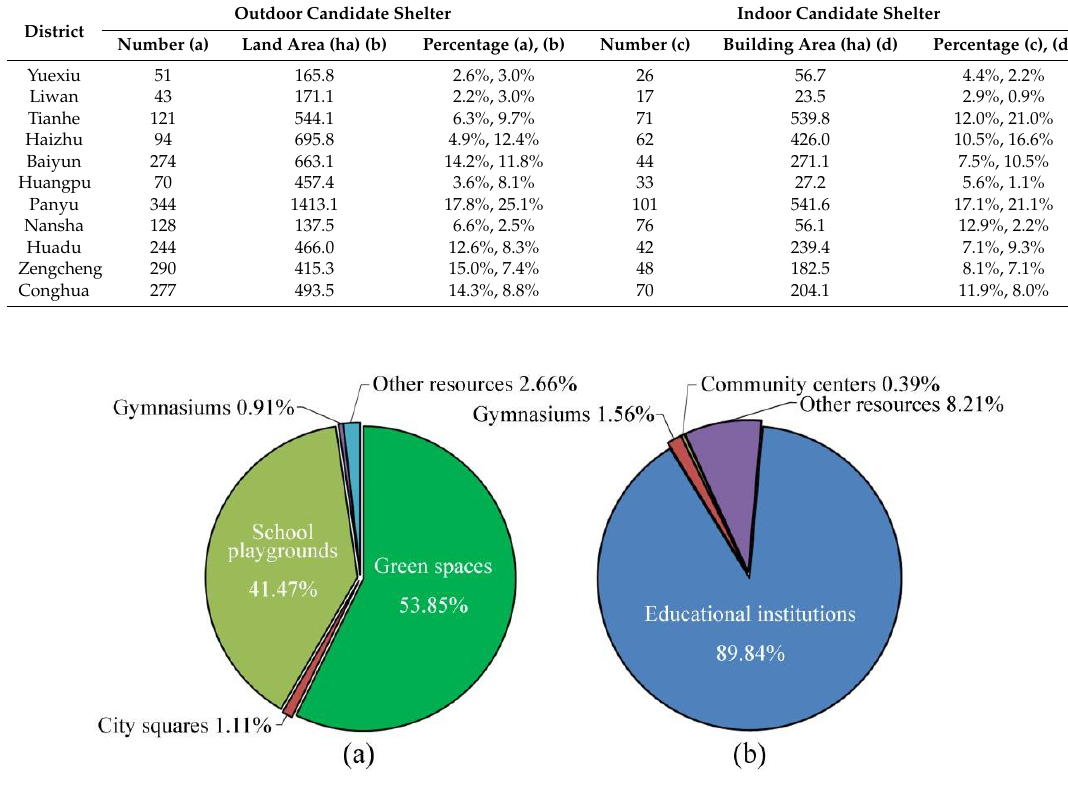
Figure 4. Composition of ( a ) outdoor available resource ( b ) indoor available resource.